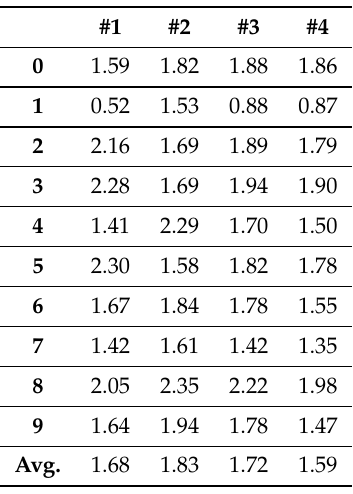
Table 9. For each visual feature MF4 , the sum of occurrence intensities (values in the encoding) was calculated. The result was considered separately for each digit, as different digits consisted of different visual features. It must be emphasized that the results in this table are relative and, while comparing them to each other is noteworthy, they should not be compared with the results from the other tables.